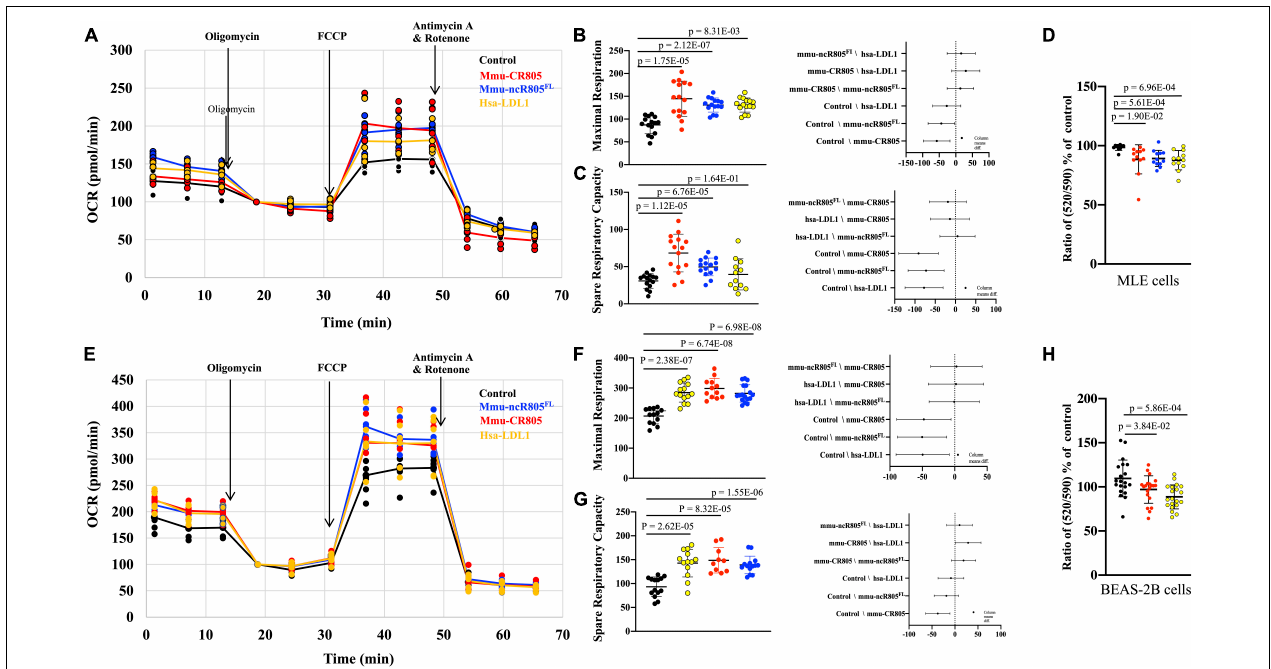
FIGURE 4 | mmu-CR805 and hsa-LDL1 increase mitochondrial bioenergetics. The MLE12 (A–D) and BEAS-2B (E–H) cells were transfected with indicated CR805-containing RNA oligos or non-targeting RNA; at 48 h post-transfection, bioenergetics were measured using a Seahorse XFe96 extracellular flux analyzer, and mitochondrial membrane potential was measured using JC-10 assay. Oxygen consumption rate (OCR) was measured at the basal level and with subsequent and sequential additions of oligomycin (1 µ M), FCCP (1 µ M), and rotenone (1 µ M) + antimycin A (1 µ M) in MLE12 (A) and BEAS-2B (E) cells. Graphs are representative of experiments with at least three biological repetitions ( Supplementary Table 3 ). Graphs of maximal mitochondrial respiration in MLE12 (B) and BEAS-2B (F) cells and spare respiratory capacity for MLE12 (C) and BEAS-2B (G) cells. Results from ANOVAs of differences between the groups are shown. (D,H) Mitochondrial membrane potential determined by a JC-10 assay, where monomer/aggregate ratios specify the depolarization of the mitochondrial membrane. All constructs containing CR805 or its human ortholog region had a lower monomer/aggregate ratio and increased (cid:49)(cid:57)